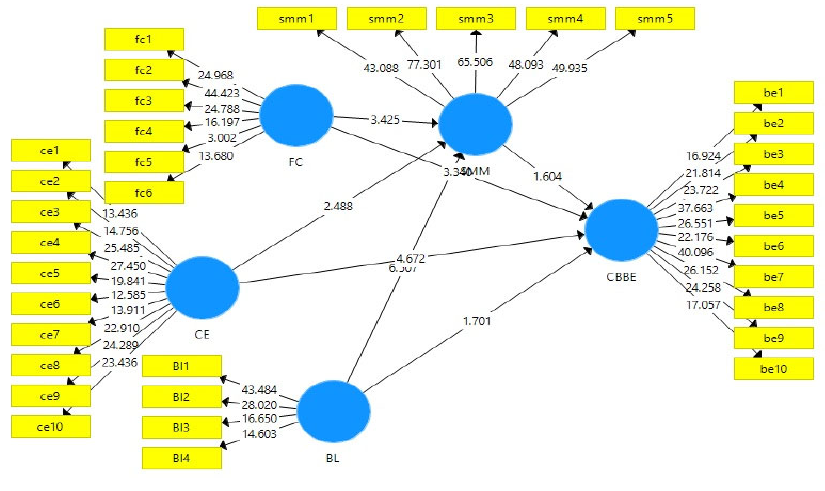
Fig. 2. Structural Equation